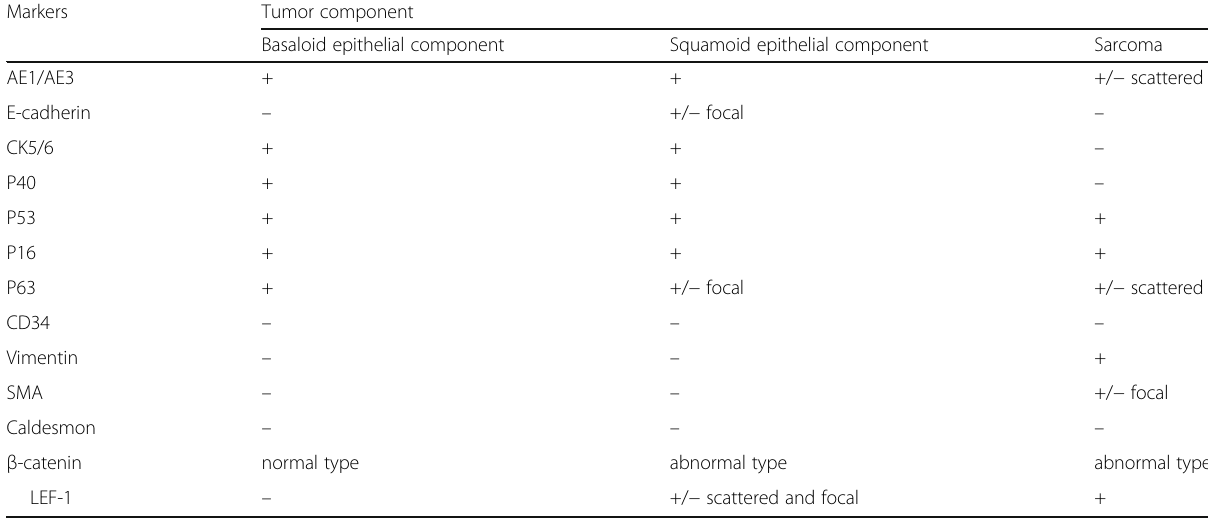
Table 1 Results of immunohistochemical analysis of the tumor Markers